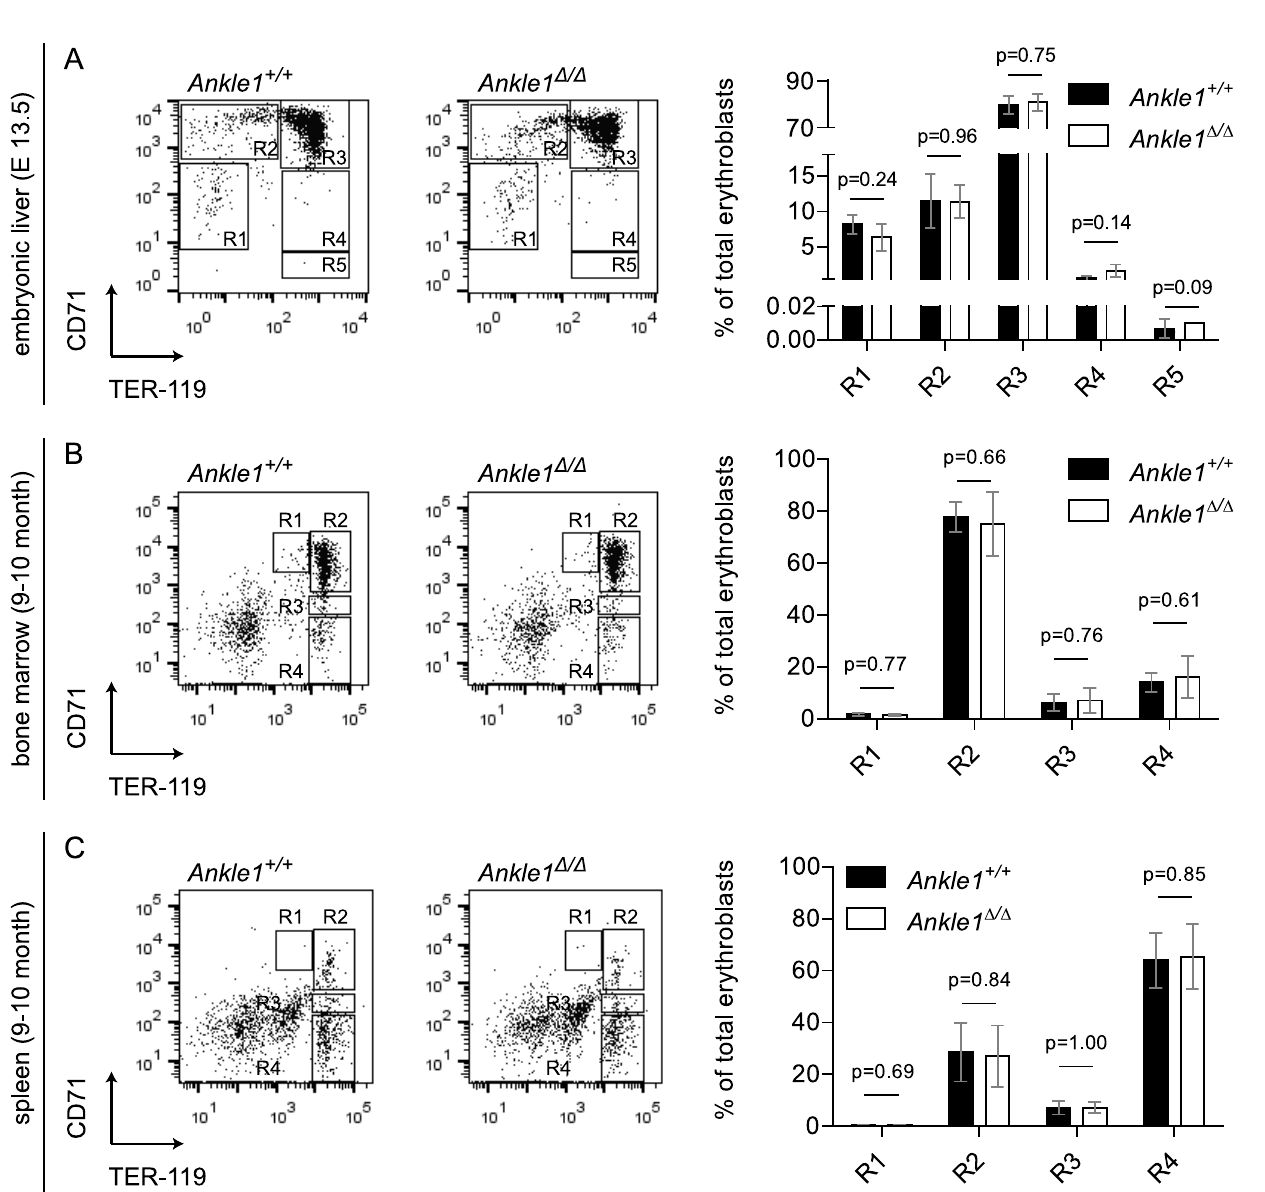
Fig 5. Flow cytometric analysis of erythroid differentiation in Ankle1 Δ / Δ mice. Cells were labeled with antibodies against Ter119 and CD71 (A) Representative dot plots of fetal liver cells from Ankle1 +/+ and Ankle1 Δ / Δ embryos (E 13.5), regions 1 – 5 (R1 – R5) represent five erythroid maturation stages, bar graphs show the percentage of labeled cells in each differentiation stage, n litter = 3; Representative dot plots of (B) Bone marrow and (C) Splenic cells from an 9 – 10 months old Ankle1 +/+ and an Ankle1 Δ / Δ mouse, regions 1 – 4 (R1 – R4) represent four erythroid maturation stages, bar graphs show the percentage of labeled cells in each differentiation stage, n = 5; error bars: standard deviation, students t test was used for determination of statistical significant differences (p (cid:1) 0.05).